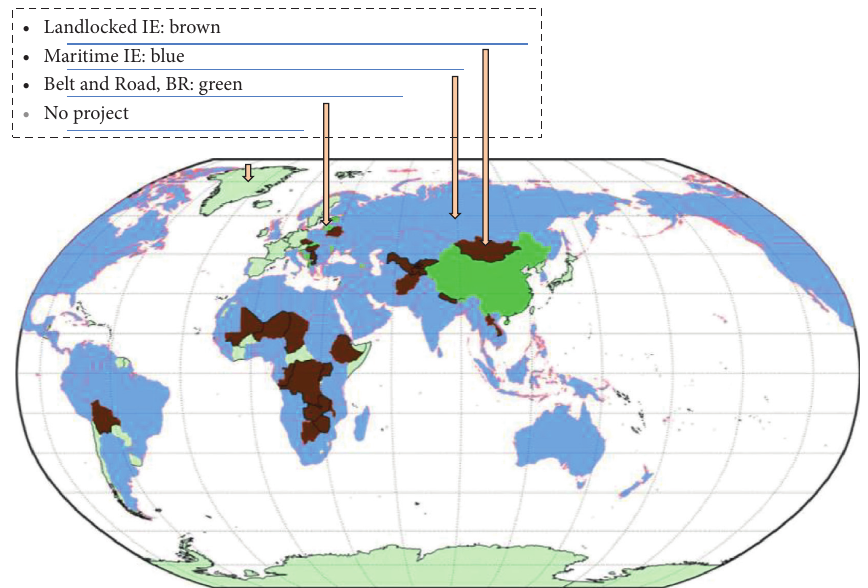
Figure 1: Spatial distribution of China’s overseas construction projects